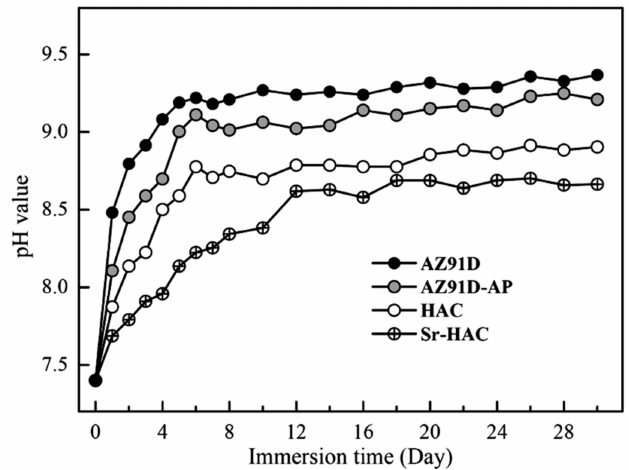
Figure 9. Variation in pH values of the Kokubo’s SBF solution immersed with AZ91D, AZ91D-AP, HAC and Sr-HAC specimens for the immersion duration of 30